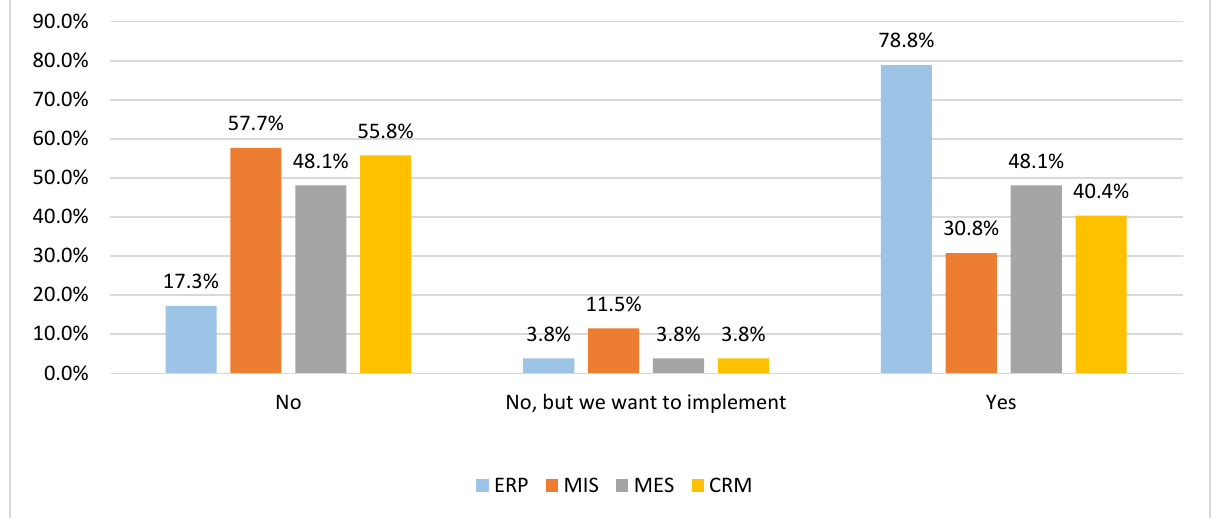
Figure 10. ERP, MIS, MES, CRM systems in the production companies.